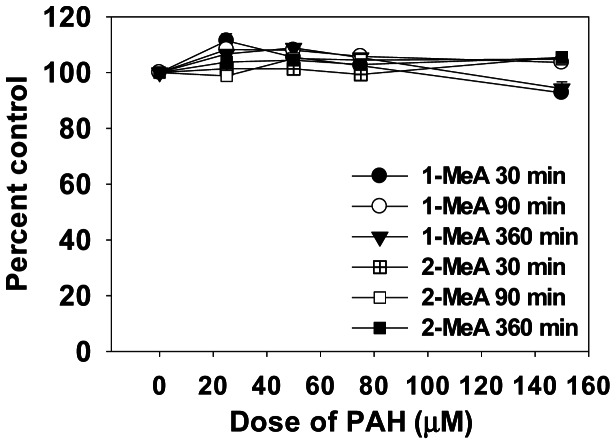
Cytotoxicity is not observed in response to 1 or 2-MeA in the C10 cells.The MTS assay observed no toxic levels of either PAH between 25–150 µM for 30 min, 1.5, or 6 h time points in the C10 cells. Mean ± SEM presented with n = 3 per study, replicated twice.